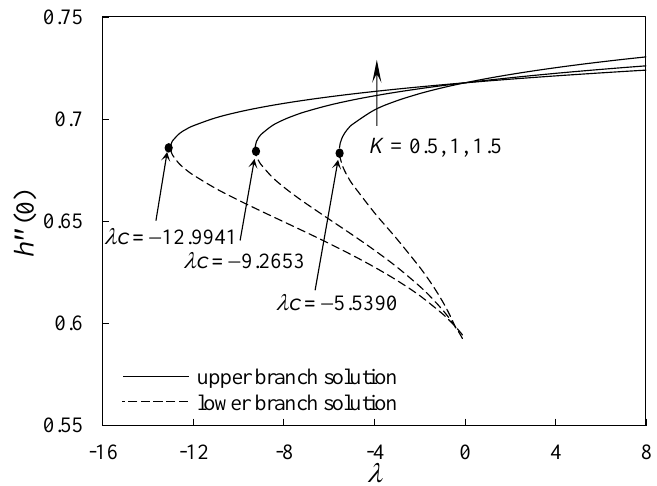
Appl. Sci. 2018 , 8 , x FOR PEER REVIEW 16 of 26   0 f    0 f  Figure 9. Variation of with  for several values of K for Ag-water nanofluid. Figure 9. Variation of f (cid:48)(cid:48) ( 0 ) with λ for several values of K for Ag-water nanofluid. Figure 9. Variation of with  for several values of K for Ag-water nanofluid.